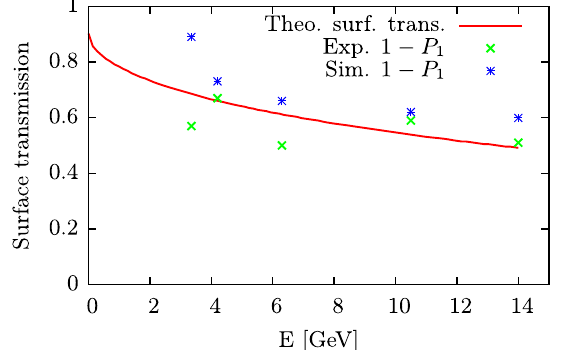
20. The experimental and simulated values of the surface transmission given by 1 − P 1 is compared with the model of Eq.